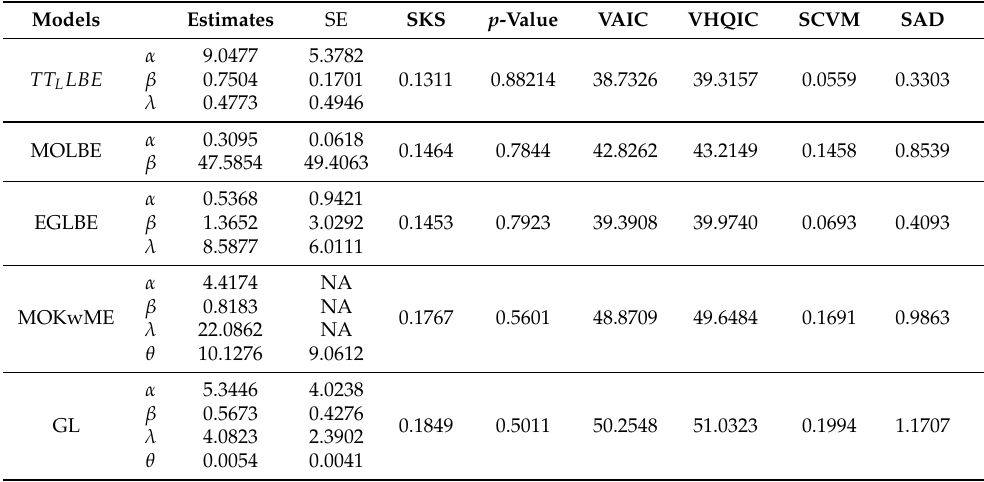
Table 9. MLE with SE, SKS test with p -value and different measures for data set II.